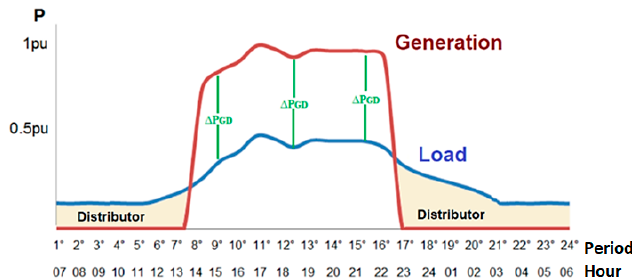
Figure 7. DG generation and load curve versus periods/hours.